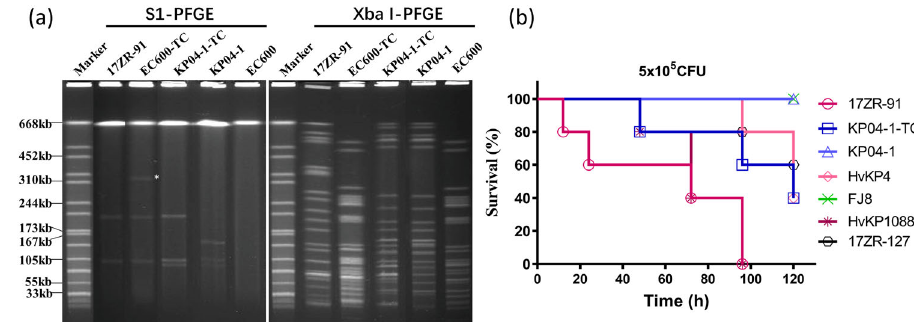
Fig. 1 PFGE pro fi les and virulence discrepancy of K. pneumoniae 17ZR-91 and corresponding transconjugants. a S1-PFGE and XbaI-PFGE pro fi les of K. pneumoniae 17ZR-91 and different transconjugants. Asterisk, conjugative fusion virulence plasmid. EC600-TC, transconjugant obtained by conjugation of plasmids from 17ZR-91 to E. coli EC600 and three plasmids were observed in this strain; KP04-1-TC, transconjugant obtained by conjugation of plasmids from EC600-TC to ST11 classical K. pneumoniae strain, KP04-1 and three plasmids were observed in this strain. b Virulence potential of K. pneumoniae isolates tested in a mouse infection assay. Survival of mice infected with 5*10 5 CFU of each K. pneumoniae at 120 h was shown ( n = 10). Statistical analysis by the Log-rank (Mantel – Cox) test was conducted for indicated curves.